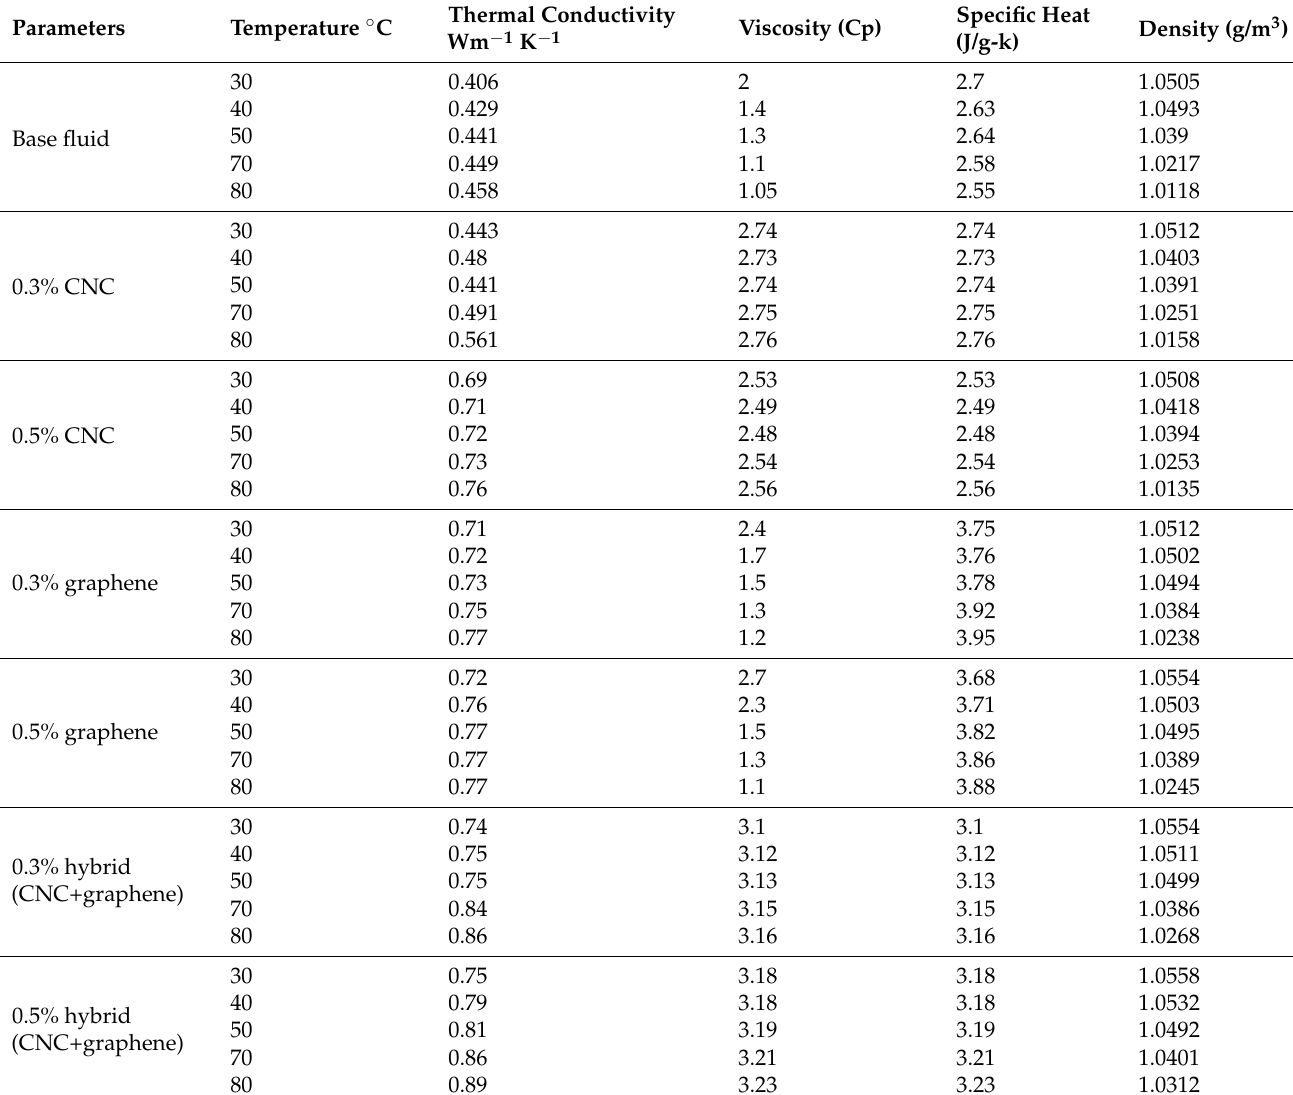
Table 3. Experimental thermo-physical properties of nanofluid and hybrid